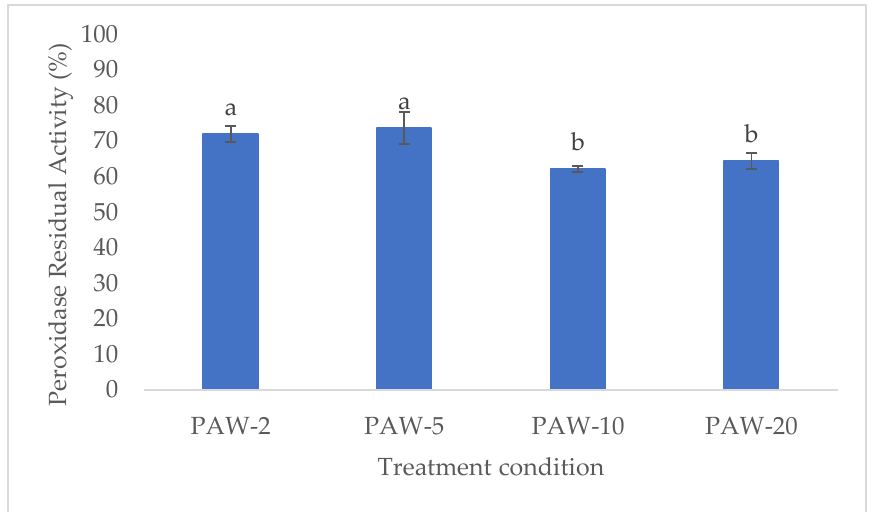
Figure 4. Peroxidase Residual Activity (RA) (%) in PAW treated rocket samples processed at different times. Means that do not share letters differ significantly ( p <